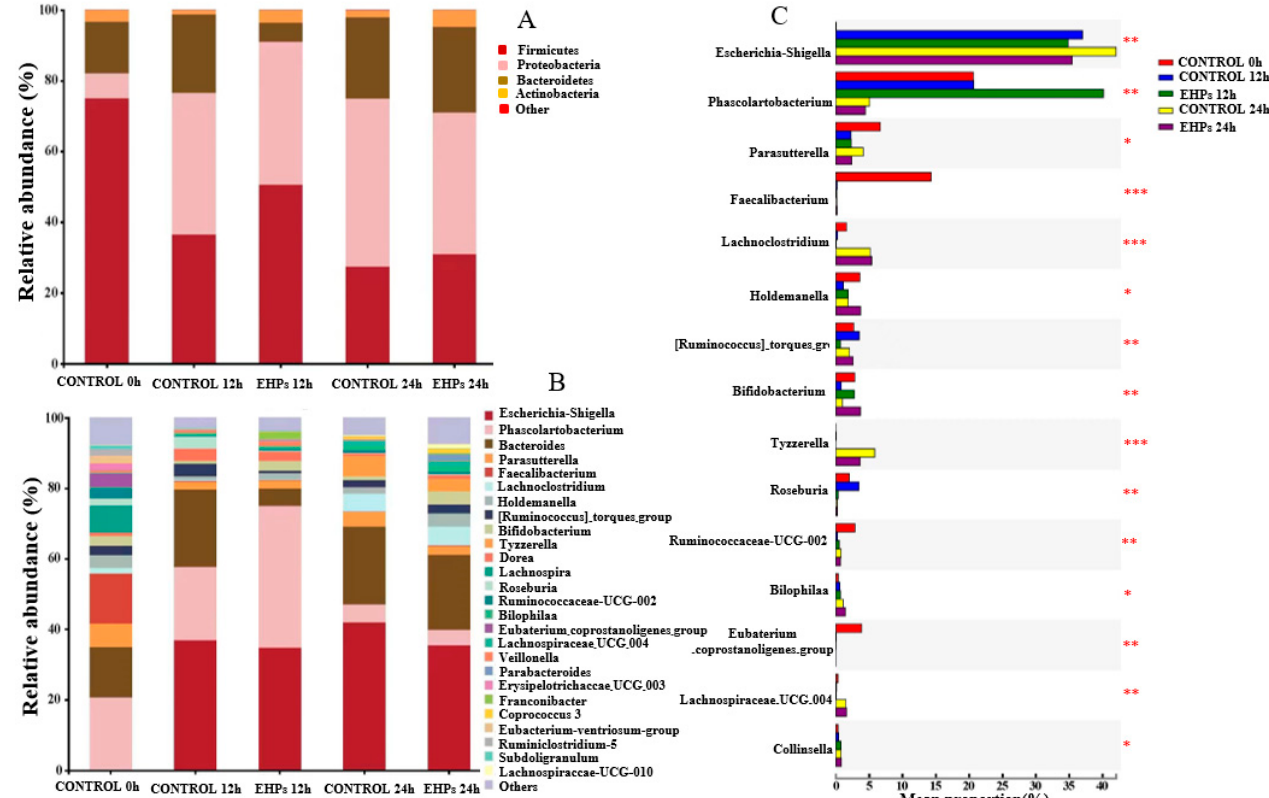
Figure 4. Relative abundance levels of the gut microbial community at the phylum ( A ), genus ( B ), and variance analysis of genus level ( C ). * p < 0.05, ** p < 0.01, *** p < 0.001 versus the control group.